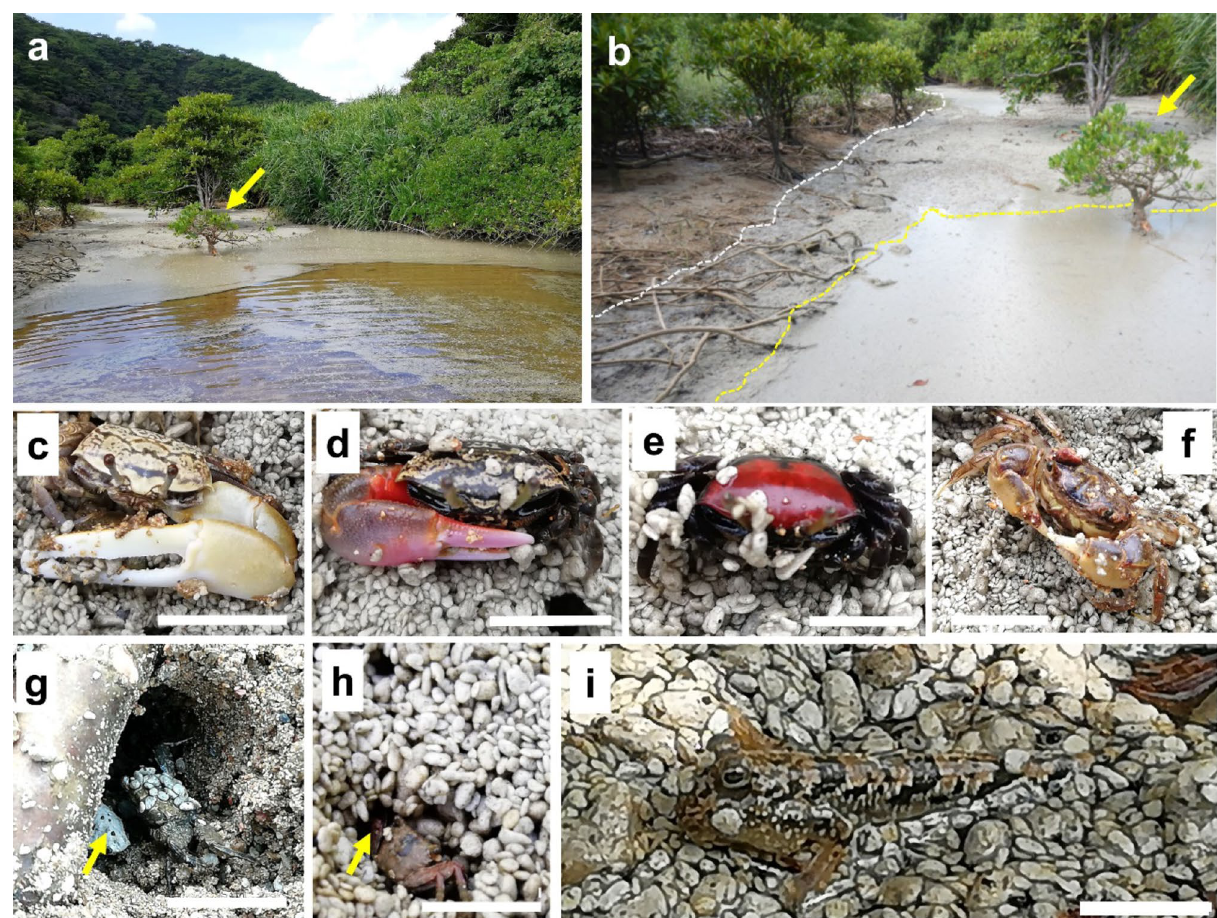
Figure 9. Behavior of mangrove organisms affected by drifting pumice. ( a ) Pumice raft adrift in a mangrove river (26°75 ′ 72.51 ″ N, 128°31 ′ 89.44" E), where a colony of Kandelia obovata (yellow arrow) and Bruguiera gymnorhiza trees coexist. ( b ) Enlarged image from (a), with the yellow arrow pointing to the same tree. The white dotted line indicates the boundary between the original mudflats and pumice-covered substrates, and the yellow dotted line marks the border of the water. ( c ) A fiddler crab ( Uca lactea lactea ) on the pumice pebbles. Video recording of the U. lactea. Behavior on the pumice-covered sediment shows the crab’s inability to return to its burrow, which had collapsed due to the pumice stones (Supplementary Video 6), and the competition between the species to acquire the burrow (Supplementary Video 7). Scale bar: 1 cm. ( d ) A fiddler crab ( Uca coaractata ) on the pumice pebbles. Scale bar: 1 cm. ( e ) A fiddler crab ( Uca chlorophthalma crassipes ) on the pumice covering mudflat. Scale bar: 1 cm. ( f ) A mitten crab ( helical epicure ) on the pumice substrate. Scale bar: 1 cm. ( g ) A sesarmid crab that cannot go back into its burrow because a pumice stone has blocked the entrance (yellow arrow); its body surface is covered with pumice grains. Scale bar: 1 cm. ( h ) A sesarmid crab tries to hide in a depression near the burrow; it is unable to hide in its burrow, which is blocked by pumice (red arrow). ( i ) A mudskipper ( Periophthalmus argentilineatus ) was placed on the pumice-covered water surface. It seemed difficult for fish to jump across the pumice-covered surface (Supplementary Video 8). Scale bar: 1